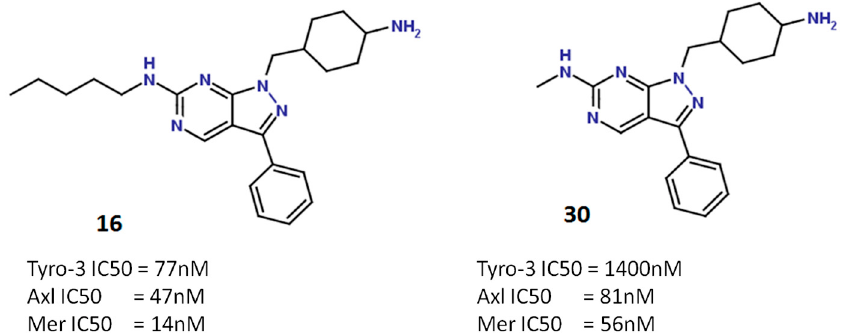
Figure 7. Structure of compounds 16 ( left ) and 30 ( right ), and their respective activities against Tyro-3, Axl and Mer.